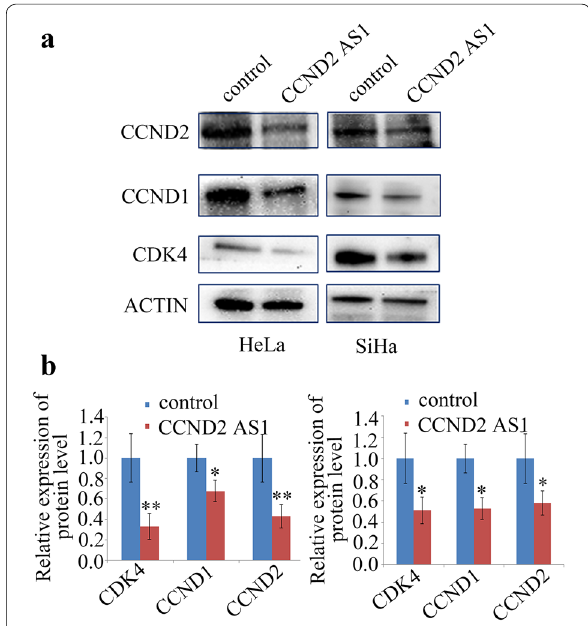
Fig. 4 Enhanced expression of CCND2 AS1 reduced CCND1, CCND2 and CDK4 expression. a CCND1, CCND2 and CDK4 expression detected by western blot in HeLa and SiHa cell lines. b Densitometry of CCND1, CCND2 and CDK4 protein expression of three independent experiments. * p < 0.05, ** p <